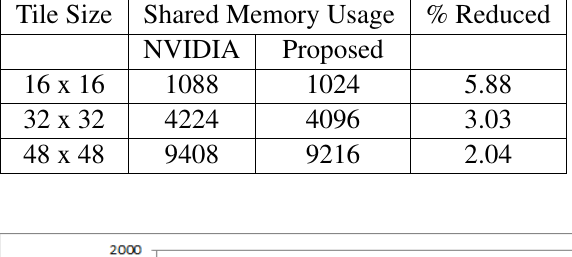
Table 3: Shared Memory Usage per Kernel Block Tile Size